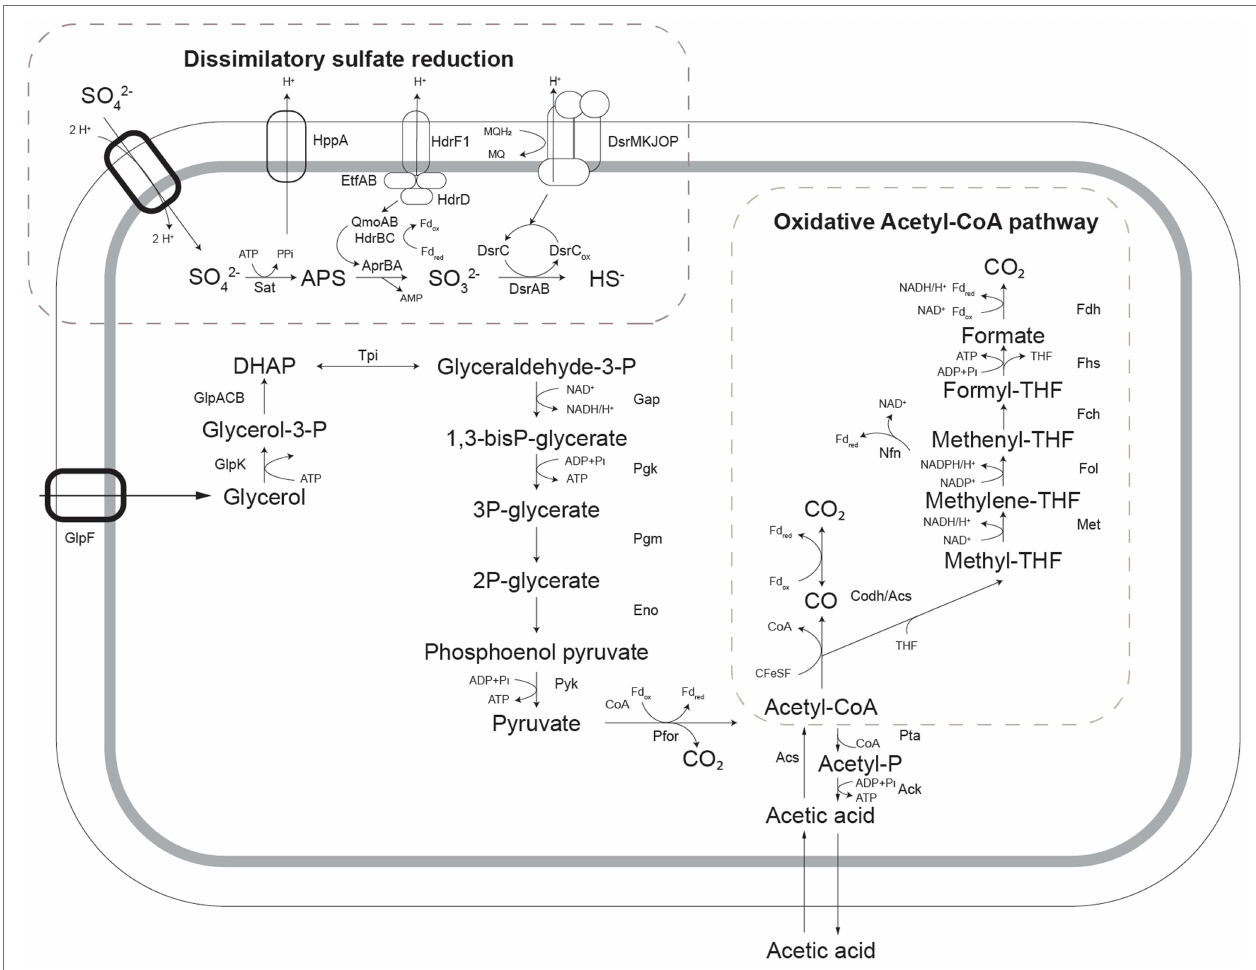
FIGURE 4 | Schematic representation of pathways for glycerol oxidation and sulfate reduction as detected in the genome of Acididesulfobacillus acetoxydans . Sat: ATP sulfurylase, Apr: APS reductase, Dsr: dissimilatory sulfite reductase, Qmo: quinone-interacting membrane oxidoreductase complex, Hdr: heterodisulfide reductase, GlpF: glycerol transporter, GlpK: glycerol kinase, Tpi: triose phosphate isomerase, Gap: glyceraldehyde-3-phosphate dehydrogenase, Pgk: phosphoglycerate kinase, Pgm: phosphoglycerate mutase, Eno: phosphoenolpyruvate hydratase, Pyk: pyruvate kinase, Pfor: pyruvate:ferredoxin oxidoreductase, Pta: Phosphate acetyltransferase, Ack: acetate kinase, Acs: acetyl-coA synthase, Codh: carbon monoxide dehydrogenase, Met: methylene-tetrahydrofolate reductase, Fol: methylene-tetrahydrofolate dehydrogenase/methenyl-tetrahydrofolate cyclohydrolase, Fch: 5-formyltetrahydrofolate_cyclo-ligase, Fhs: Formate- tetrahydrofolate ligase/ formyl-H4F synthethase, Fdh: formate dehydrogenase, Nfn: NADH-dependent reduced ferredoxin:NADP +